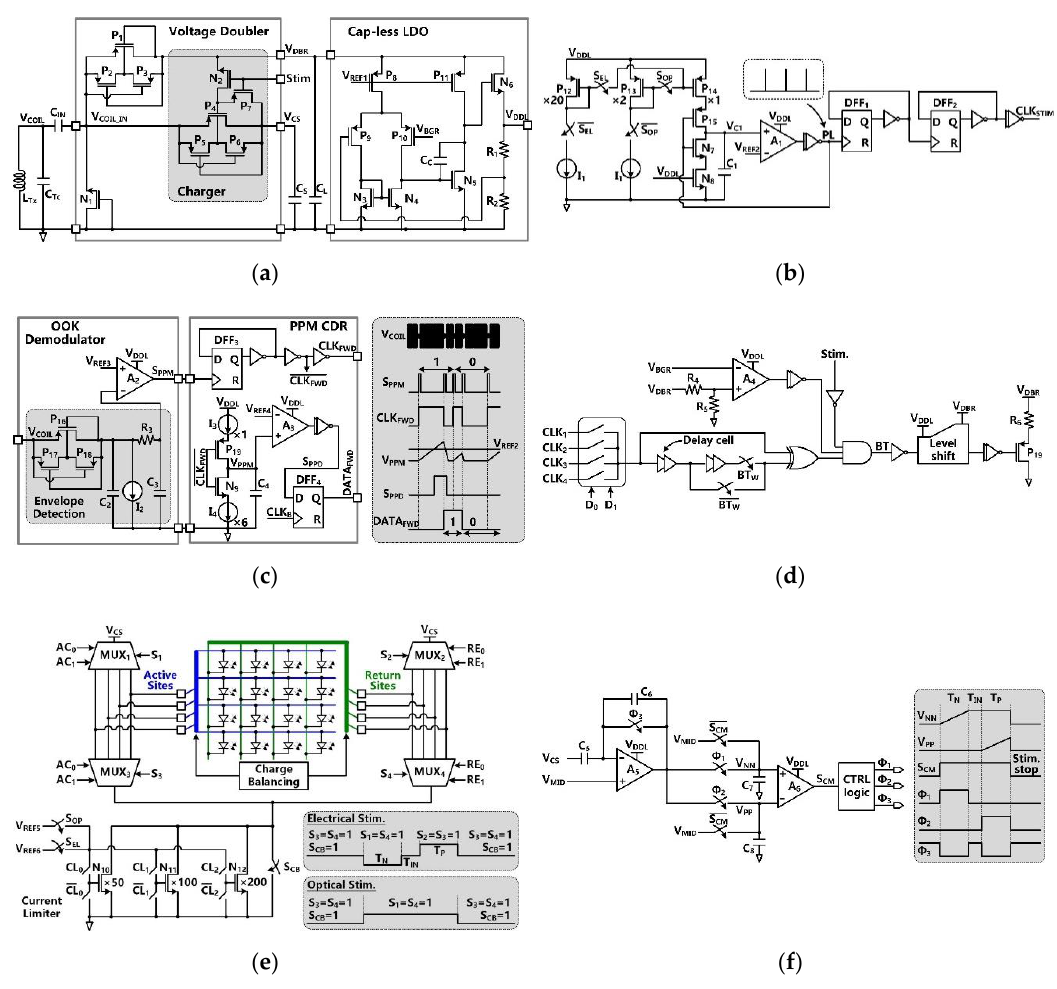
Figure 3. Schematic diagram of ( a ) the voltage doubler with built-in charger and the cap-less LDO, ( b ) the clock generator for the timing of stimulation and charging functions, ( c ) the OOK demodulator and PPM-CDR in forward data telemetry, ( d ) the LSK back telemetry, ( e ) the stimulation driver in H-bridge configuration, and ( f ) the active charge balancing (CB) circuit.